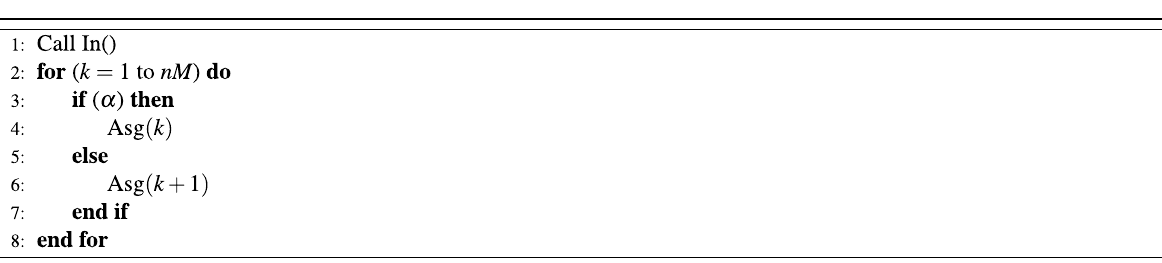
Table 4. Randomized-NI function (RNI( nM